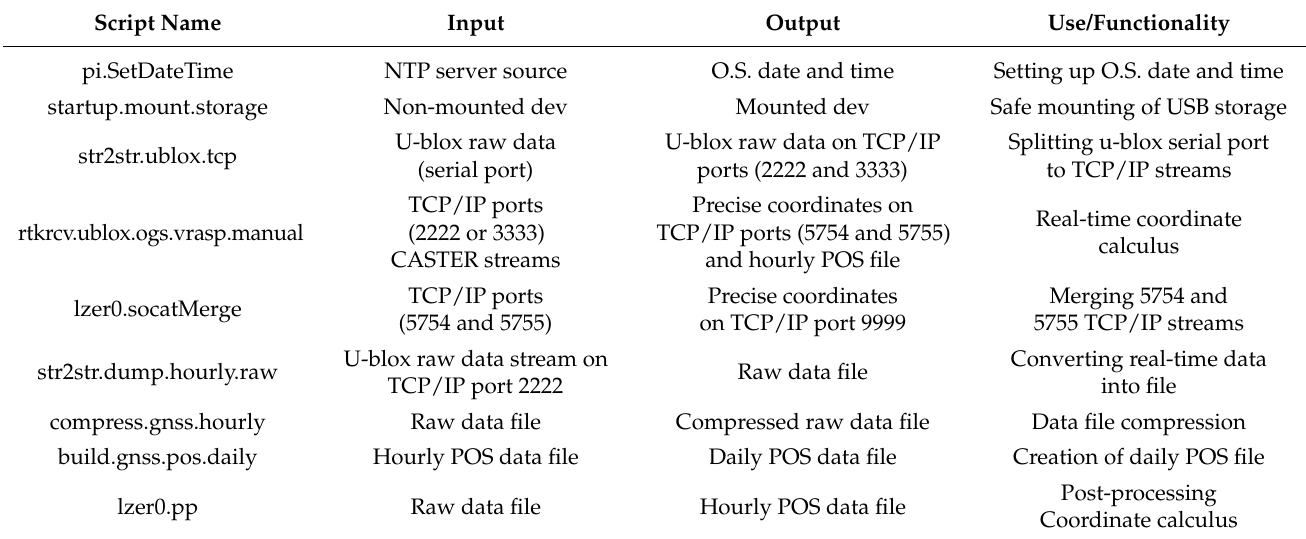
Precise coordinates